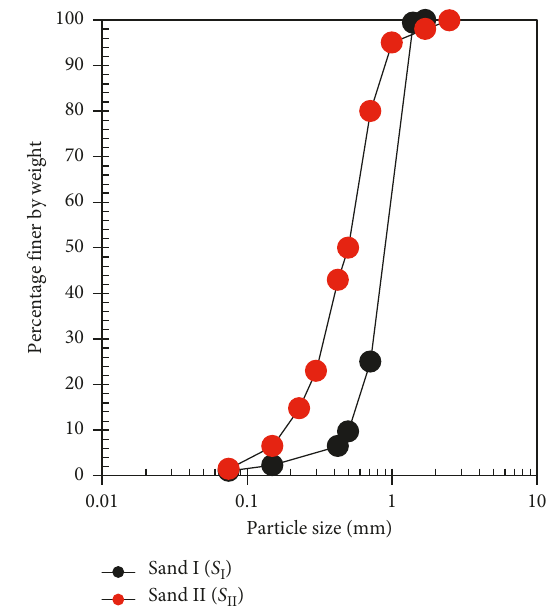
Figure 1: Grain size distribution for sand I ( S